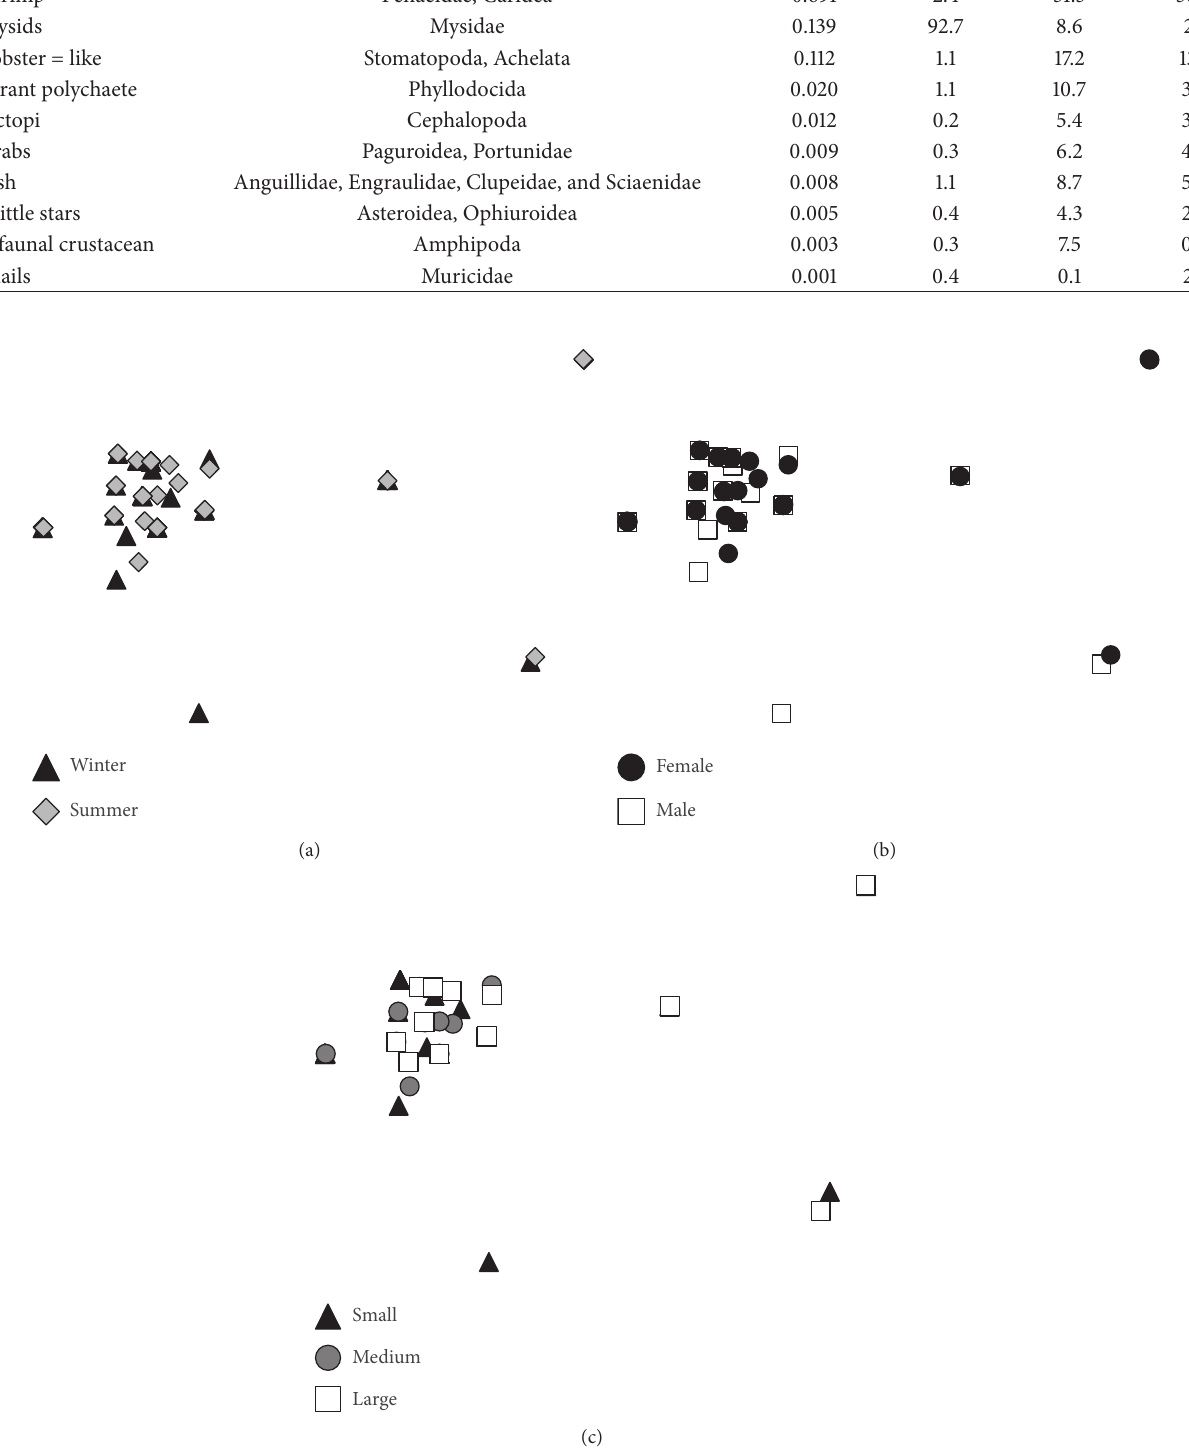
Figure 3: Nonmetric MDS analysis of the Panama grunt according to season (a), sex (b), and fish length (c). The stress value was